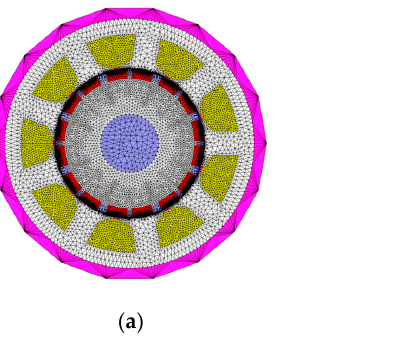
Figure 8. The operation characteristics of DHPCM-SPMPs.